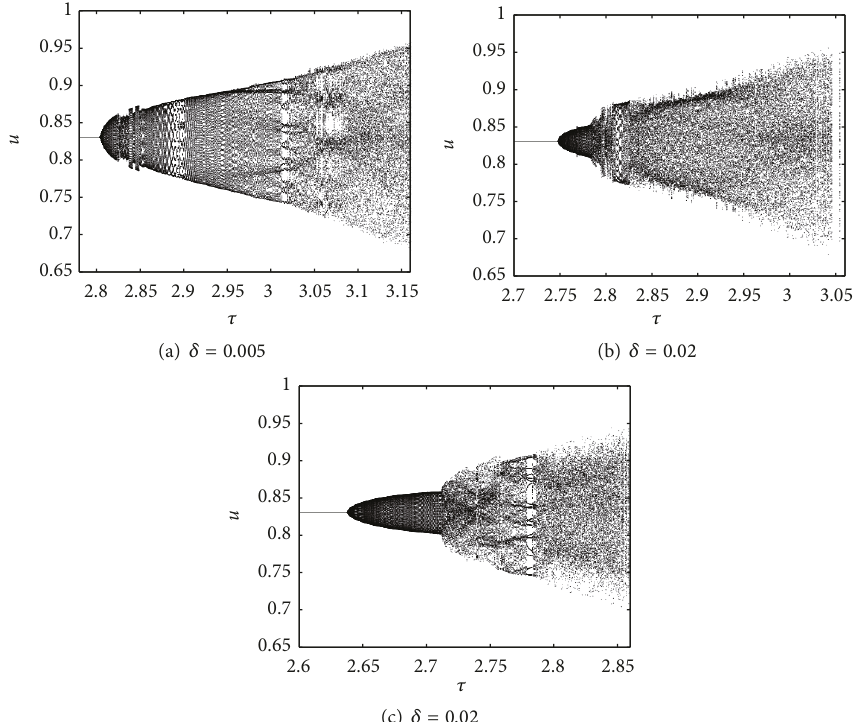
Figure 11: Neimark-Sacker bifurcation diagram of the coupled dynamical network with different coupling strengths. Globally coupled network is applied, 𝑁 = 5 . Other parametric conditions are the same with Figure